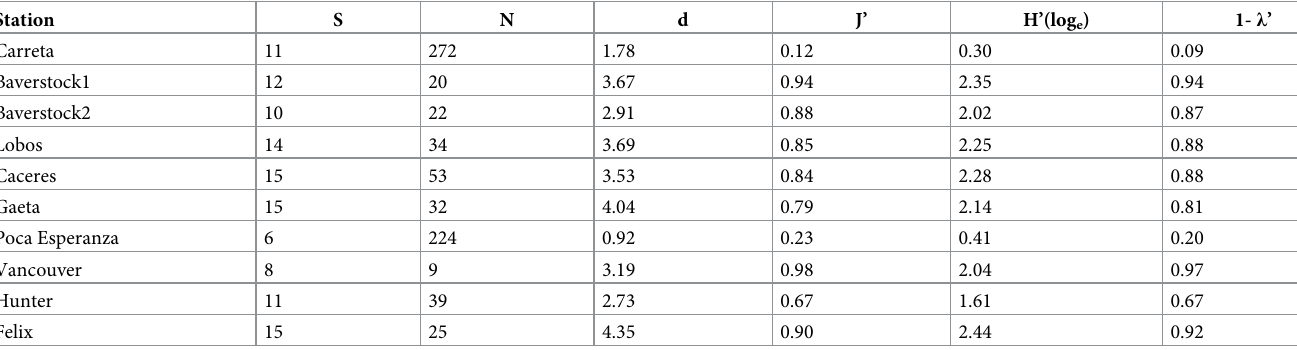
Table 5. Deep-sea benthic community summary statistics.